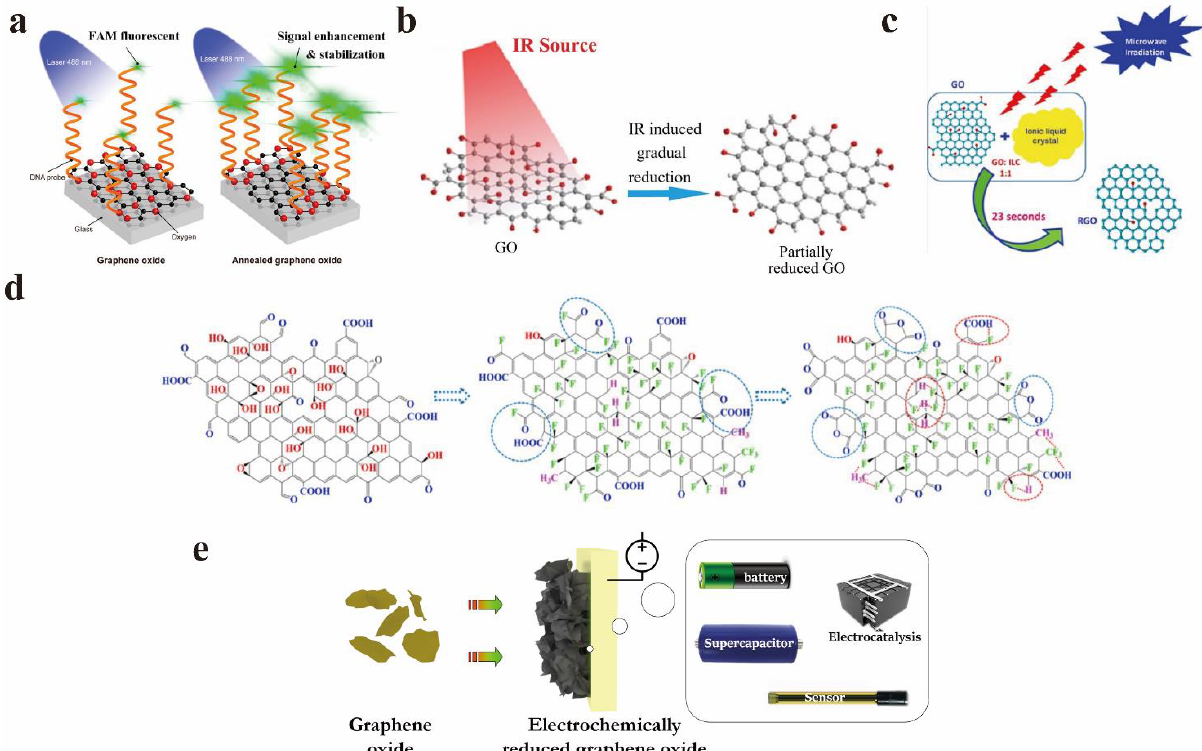
Figure 3. Summary of common reduction methods: ( a ) Annealing. Reprinted with permission from [20]. Copyright 2022, American Chemical Society. ( b ) Infrared radiation. Reprinted with permission from [24]. Copyright 2014, IOP Publishing Ltd. ( c ) Using the dielectric properties of ILC to promote rapid microwave heating. Reprinted with permission from [30]. Copyright 2022, Elsevier. ( d ) Fluorination method. Reprinted with permission from [23]. Copyright 2020, Elsevier. ( e ) Electrochemical reduction. Reprinted with permission from [31]. Copyright 2022, Elsevier.